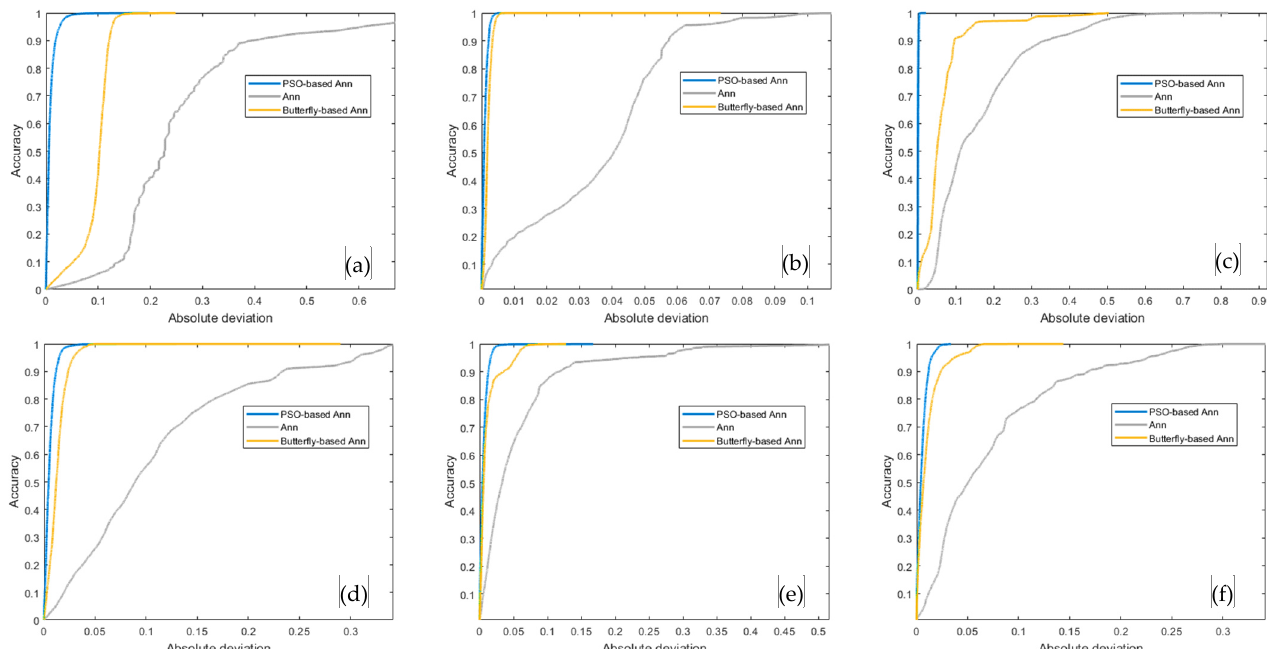
Figure A5. REC curves for ANN-BR, PSO-ANN, and BOA-ANN for ( a ) HWS 1 ( b ) HWS 2 ( c ) HWS 3